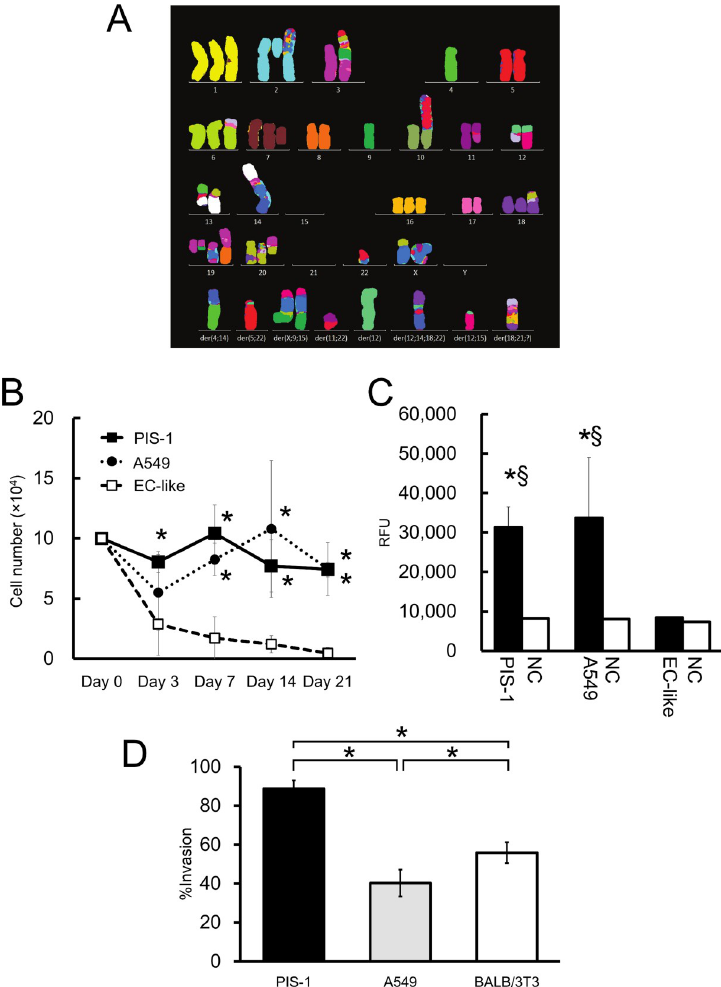
Fig 3. Malignant potential of PIS cells. (A) Representative multicolor fluorescence in situ hybridization (mFISH) karyogram from PIS-1 cells. (B) Starvation assay. Three cell groups (PIS-1, A549, EC-like) were incubated with each serum-free medium. � p < 0.05 vs. EC-like cells. (C) Colony formation assay. Cell suspensions containing 5 × 10 3 PIS- 1, A549, or EC-like cells were seeded on the semisolid soft agar layer. After seven days of incubation, the formed colonies and soft agar were dissolved and stained with fluorescent dye followed by reading with a fluorescence plate reader. RFU: relative fluorescence units, NC: negative control, � p < 0.05, vs EC like cells; §p < 0.05, vs negative control of each group. (D) Invasion assay. To evaluate the invasion and migration potential of PIS-1 cells, Matrigel invasion chambers (24-well) and Biocoat control culture inserts were used. BALB/3T cells were used for negative control according to the datasheet. Cell suspension (2.5 × 10 4 ) and serum-free medium were placed into the upper wells, and the incubation medium with FBS was added into lower wells. After 22 hours of incubation, the cells that migrated or invaded through membranes were counted microscopically. The percent invasion was defined as the ratio of invaded to migrated cells. Error bars show standard deviation. � : p < 0.05.